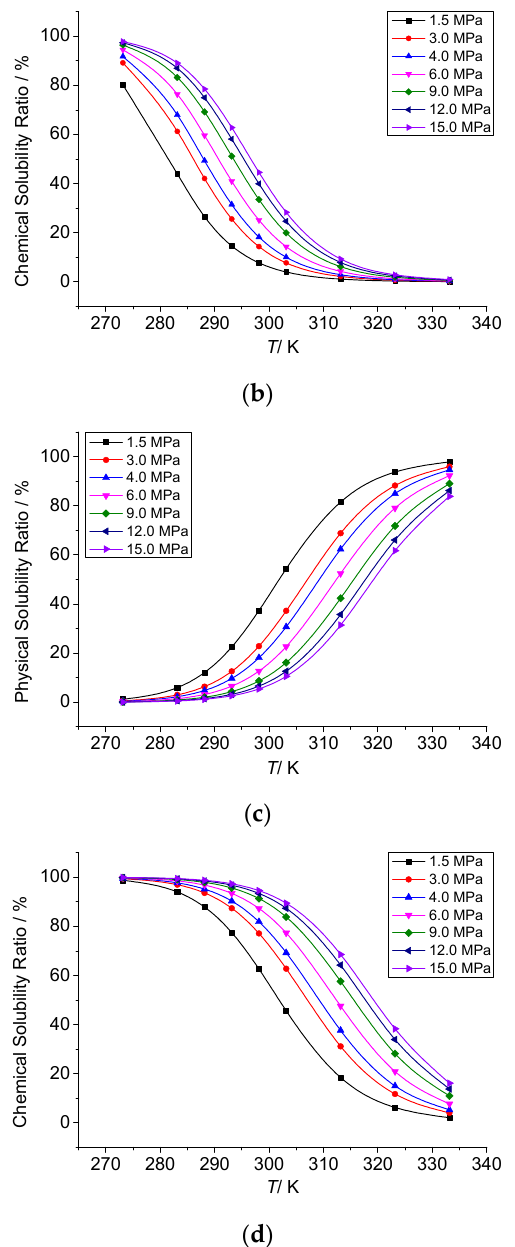
Figure 6. Variation curves of physical and chemical solubility ratios with temperature. ( a ) Physical solution of gas 1; ( b ) chemical solution of gas 1; ( c ) physical solution of gas 4; ( d ) chemical solution of gas 4.